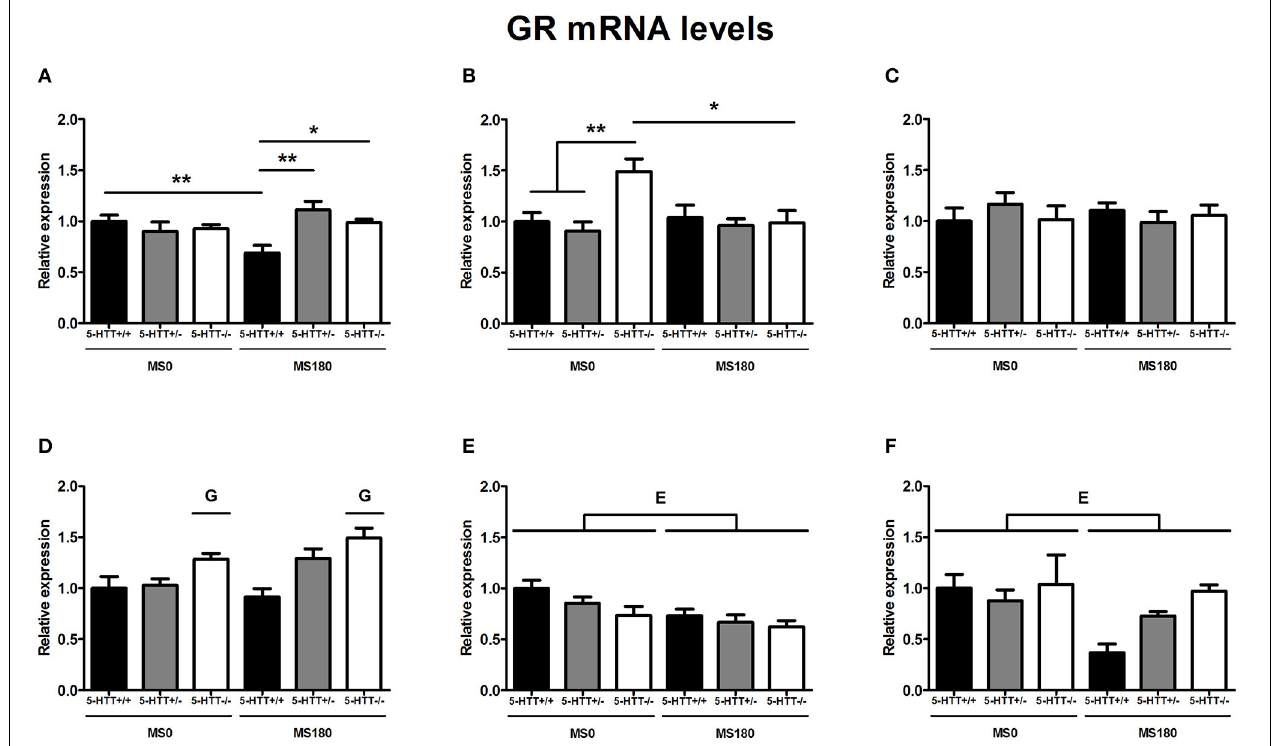
FIGURE 1 | Glucocorticoid receptor (GR) mRNA levels in the dorsal medial prefrontal cortex (mPFC) (A) dorsal hippocampus (B) central amygdala (C) ventral mPFC (D) ventral hippocampus (E) and the anterodorsal bed nucleus of the stria terminalis (BNST) (F) of serotonin transporter (5-HTT) homozygous knockout (5-HTT − / − ), heterozygous knockout (5-HTT + / − ), and wild-type (5-HTT + / + ) rats exposed to daily 3h separations (MS180) or a control treatment (MS0). GR mRNA levels in the dorsal mPFC and dorsal hippocampus were found to be affected by a